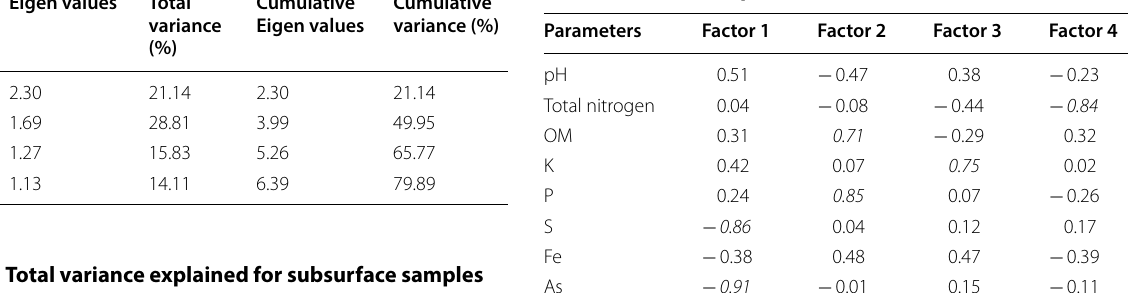
** Italic values indicate the significant correlation between the various chemical parameters Table 5 Total variance explained for surface samples Factor